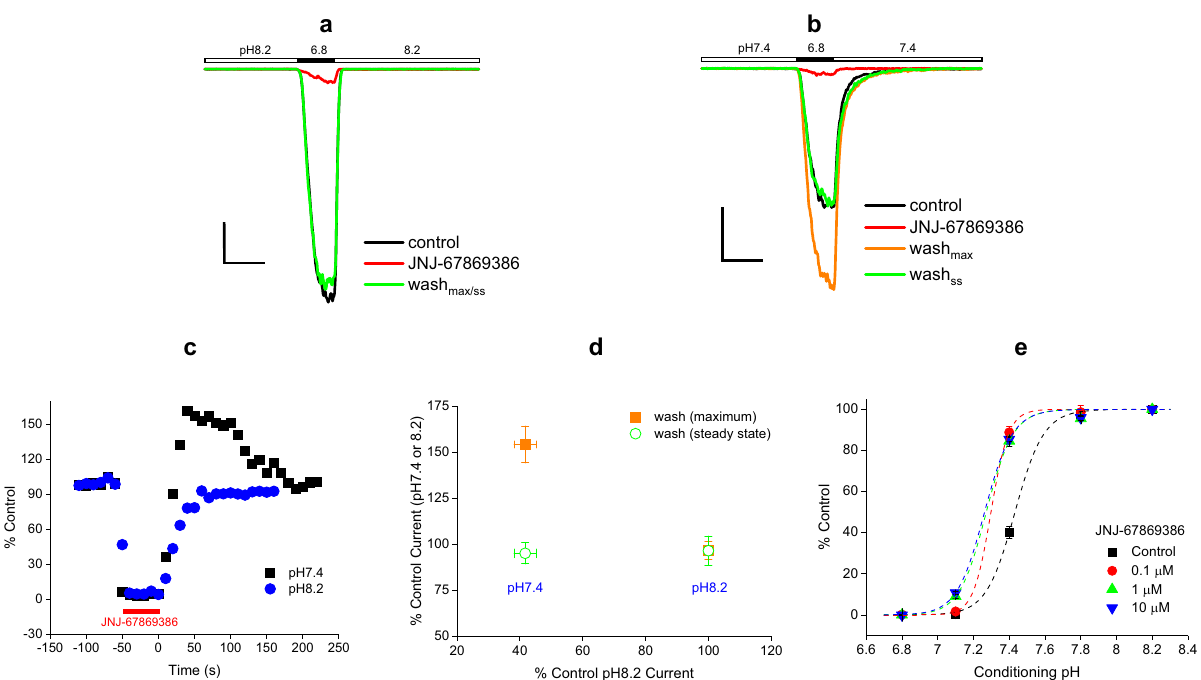
Fig. 2 Effect of JNJ-67869386 on the pH dependence of recovery from inhibition and of steady-state desensitization. a and b Traces of pH 6.8-induced currents from an ASIC1a-expressing cell with and without 100 nM JNJ-67869386 at the holding pH of 8.2 ( a ) and 7.4 ( b ). Scale bars: 100 ms/100pA (horizontal/vertical). c Time courses of inhibition of pH 6.8-induced current by 100 nM JNJ-67869386 and recovery (wash) from inhibition at the holding pH of 8.2 and 7.4 from the same cell. Current amplitudes are normalized to that of pre-JNJ-67869386 controls at the respective pHs. Wash starts at t = 0 s. d Summary of all experiments like ( c ). The average normalized maximal (solid squares) and steady-state (open circles) wash current amplitude ( n = 4 for both pH 7.4 and 8.2) is plotted against the pre-JNJ-67869386 control current amplitude (normalized to the pH 8.2 control; n = 4). The maximal and steady-state wash values at pH 7.4 are statistically different ( p < 0.01; Two-tailed Student ’ s t -test). V h = − 60 mV. e Effect of JNJ-67869386 (0.1 – 10 µ M) on the pH dependence of steady-state desensitization. pH 50 = 7.43 ± 0.01 ( n = 14), 7.30 ± 0.03 ( n = 8), 7.27 ± 0.01 ( n = 4) and 7.26 ± 0.01 ( n = 4) for control, 0.1, 1, and 10 µ M JNJ-67869386, respectively. Data at all concentrations are statistically different from control ( p < 0.001; Two-way